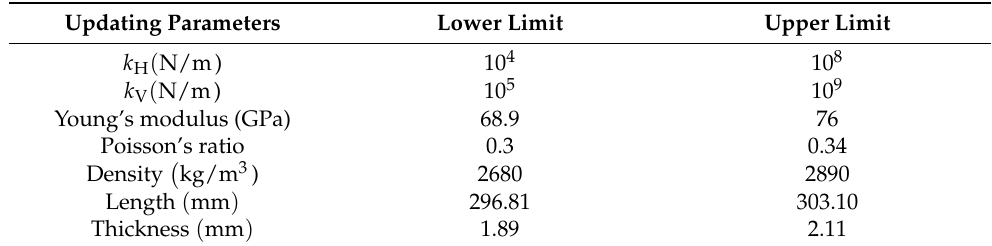
Table 8. Updating parameter